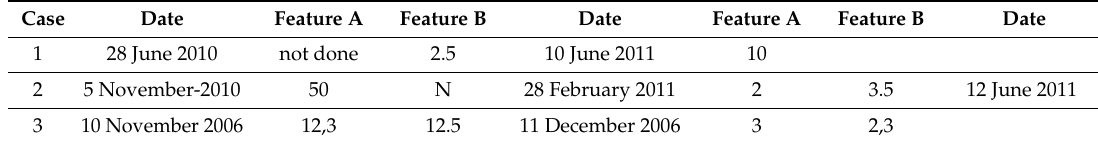
Table 5. ALSFRS input table using a comma-separated values file.